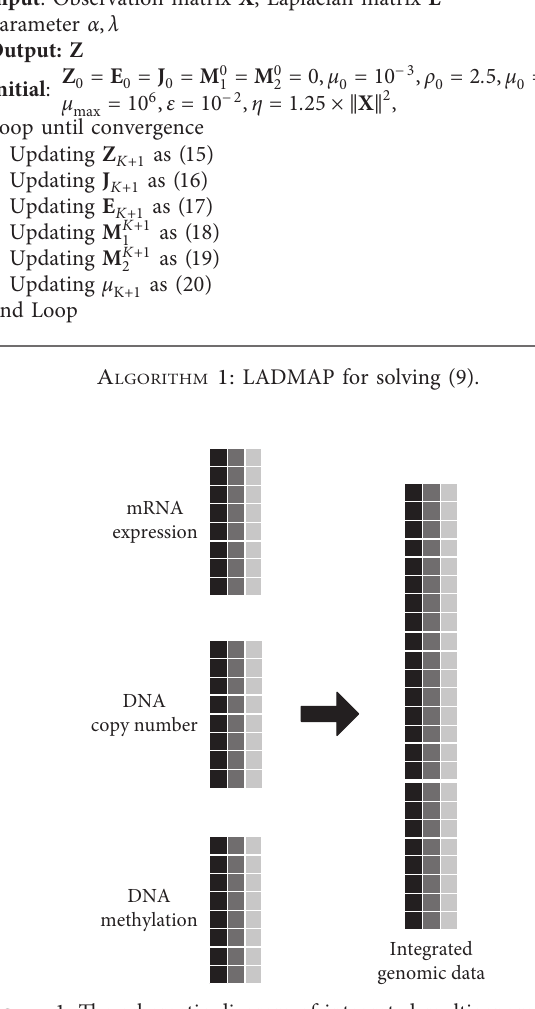
Figure 1: The schematic diagram of integrated multigenome data.